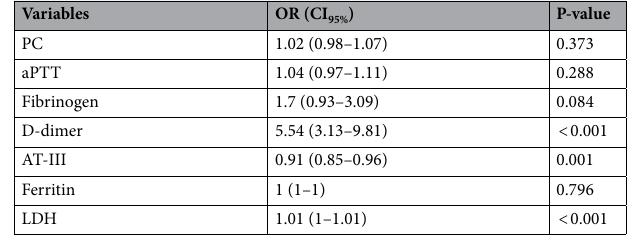
Table 4. Multiple binary logistic regression analysis of predictor variables of severe illness. LDH lactate dehydrogenase, PC prothrombin concentration, aPTT activated partial thromboplastin, ATT-III antithrombin- III. *Statistically significant.